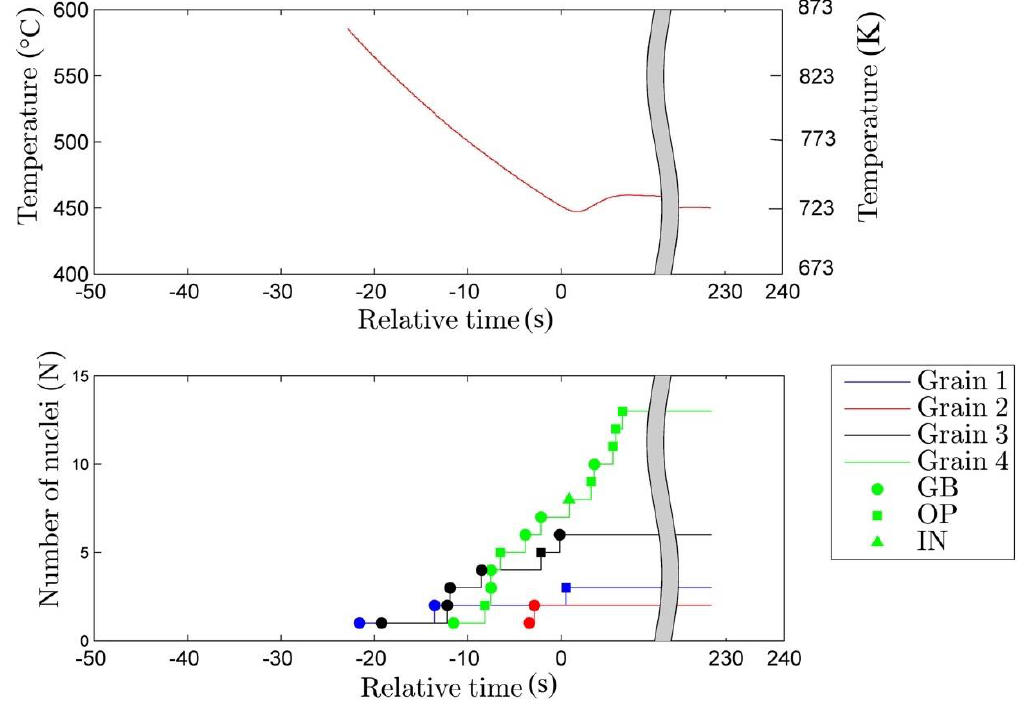
Figure 3. Temperature and nucleation sequence versus time of bainitic ferrite plates in Fe-0.2C-1.5Mn-2.0Cr during isothermal holding treatment at 723 K (450 °C).